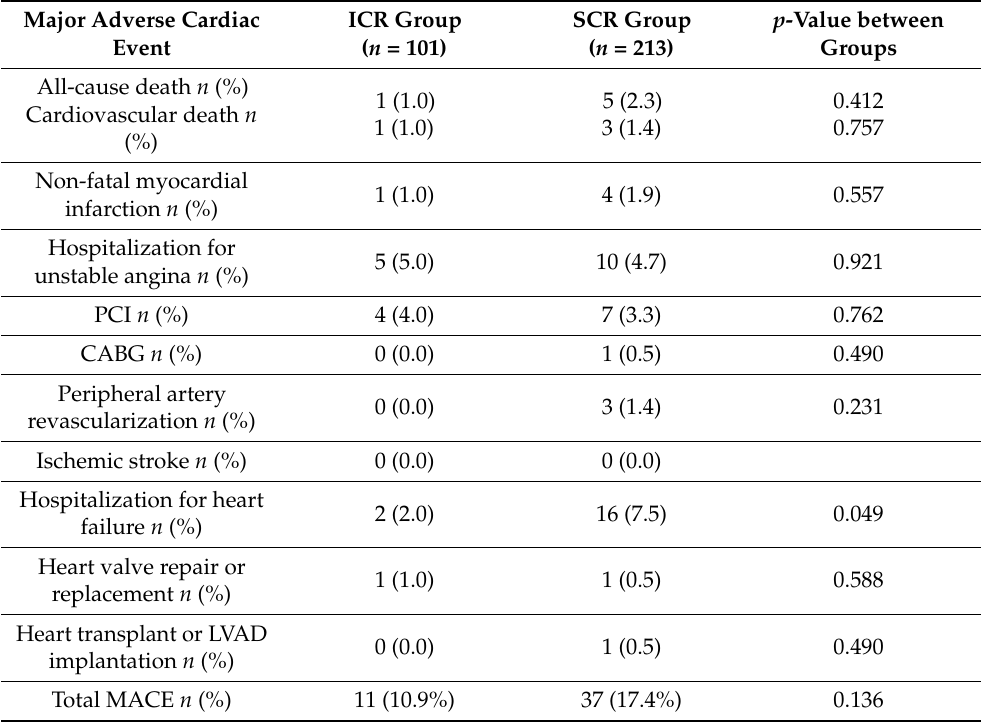
Table 3. Incidence of major adverse cardiac events in the long-term follow-up after completion of cardiac rehabilitation in patients undergoing intensive cardiac rehabilitation (ICR group) and standard cardiac rehabilitation (SCR group).